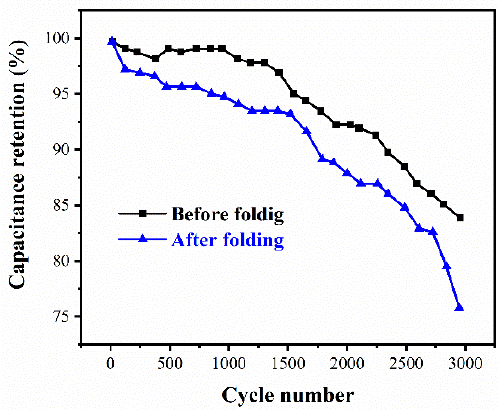
Figure 8. Capacitance of MXene/CNF–PANI aerogel films before and after 500 folding cycles and 3000 charge/discharge cycles at a constant charge/discharge current density. Table 1. MXene/CNF–PANI aerogel films comparison of the performance of capacitors with other capacitors.